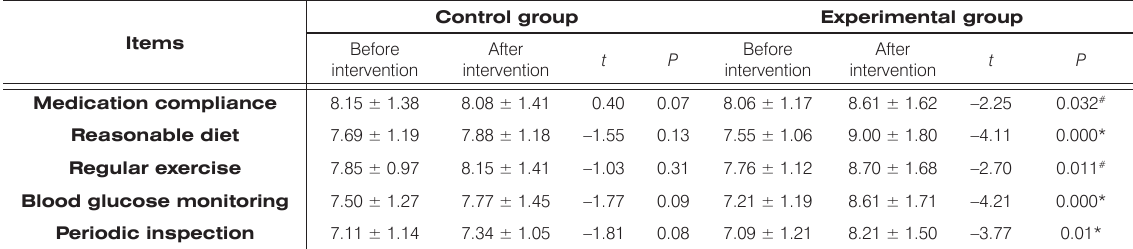
Table 1. Patient compliance before and after the intervention (M ± SD, n = 59) Notes: # Intragroup comparison, P < 0.05; *intragroup comparison, P ≤ 0.01; M = mean value; SD = standard deviation.